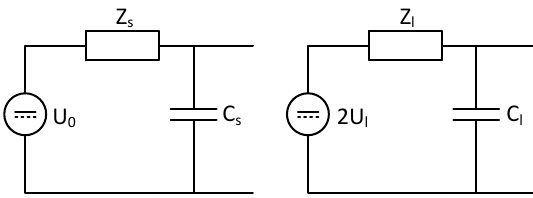
Figure 2. Equivalent circuits of droop controlled sources ( left ) and constant power loads ( right